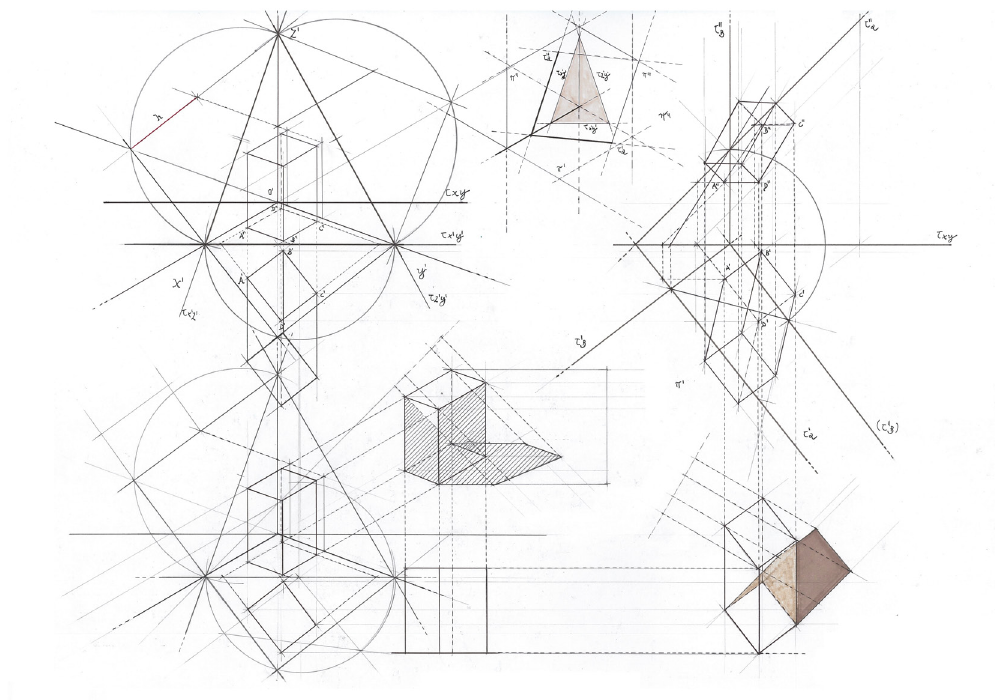
Demonstration between separate models referred to the homological relations between the parallel projection and orthogonal projection , 2021, china, marker, lapis, on cardboard, 29.7x49.0